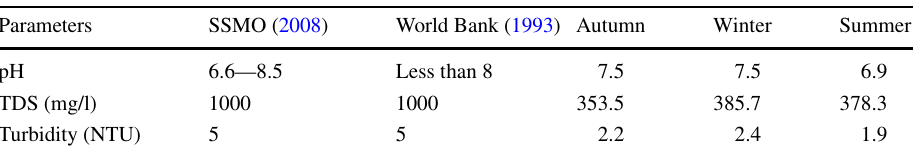
Fig. 2 Seasonal quality of water sources